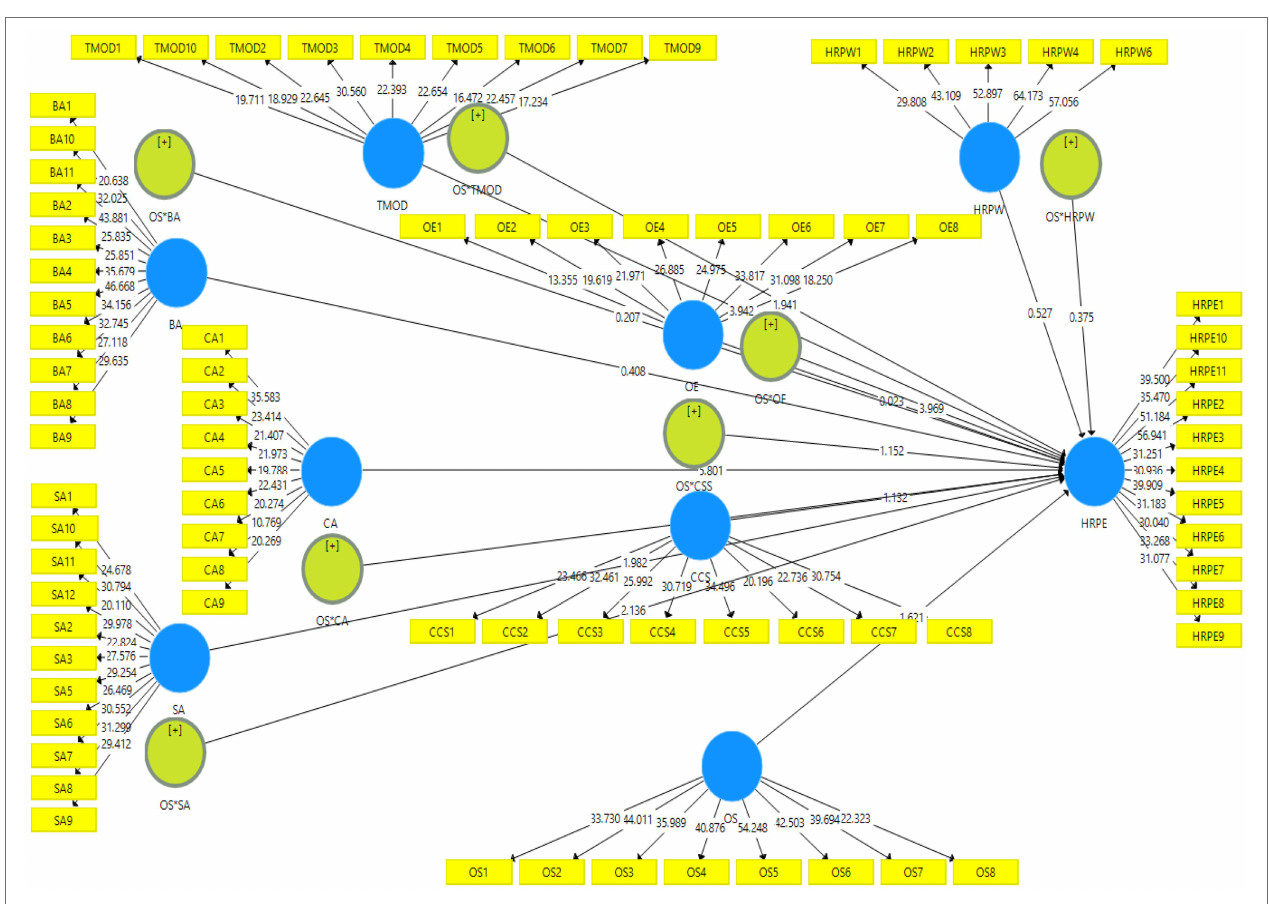
FIGURE 4 | Structural model (moderating